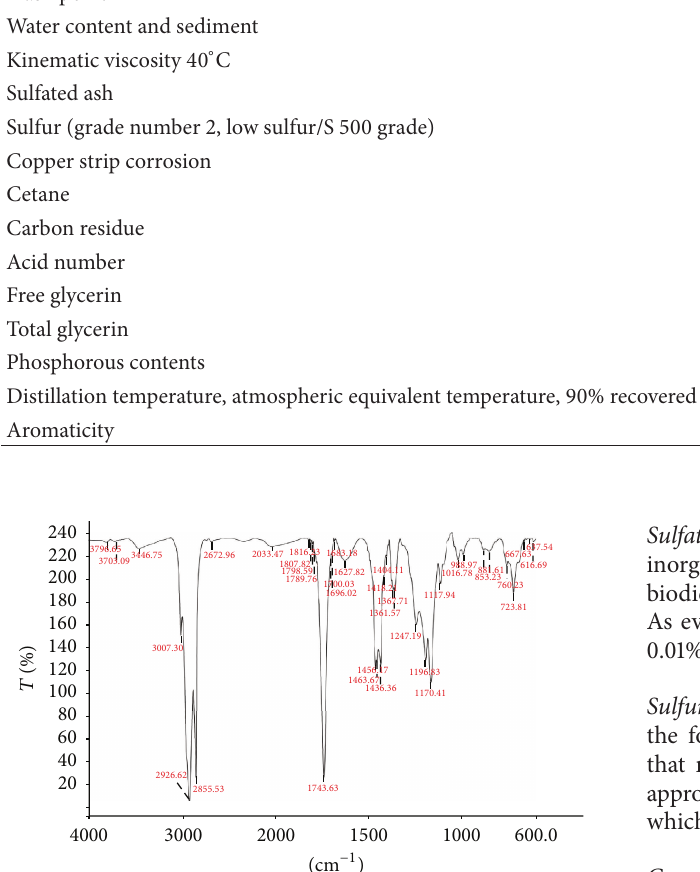
compared to storing diesel